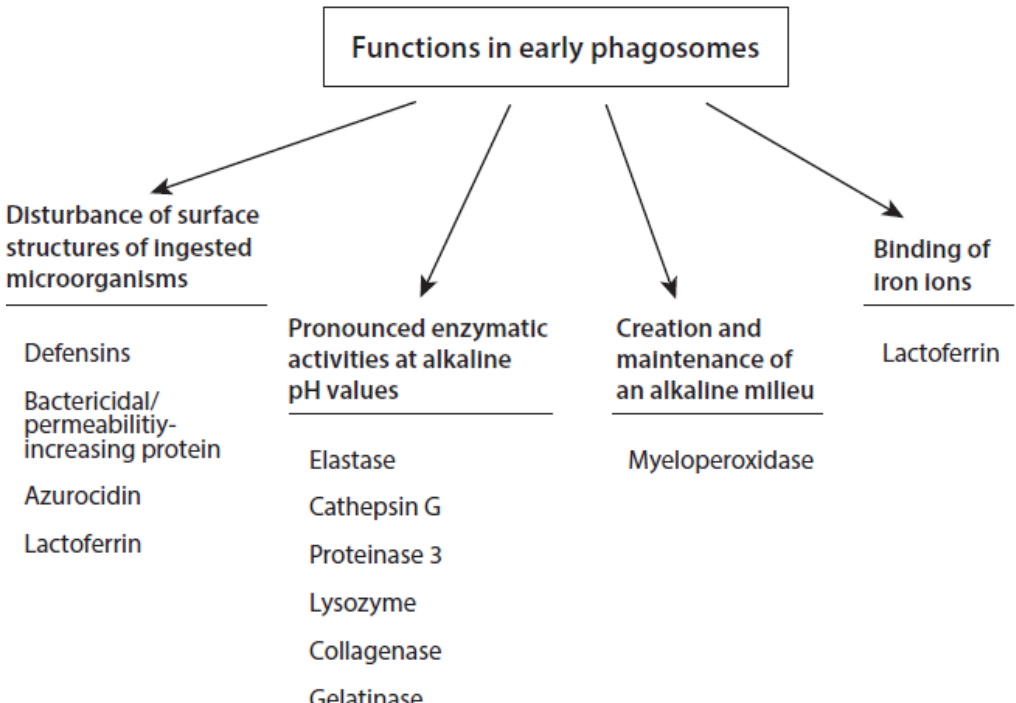
Figure 2. Major functions of granule constituents of PMNs in early phagosomes.